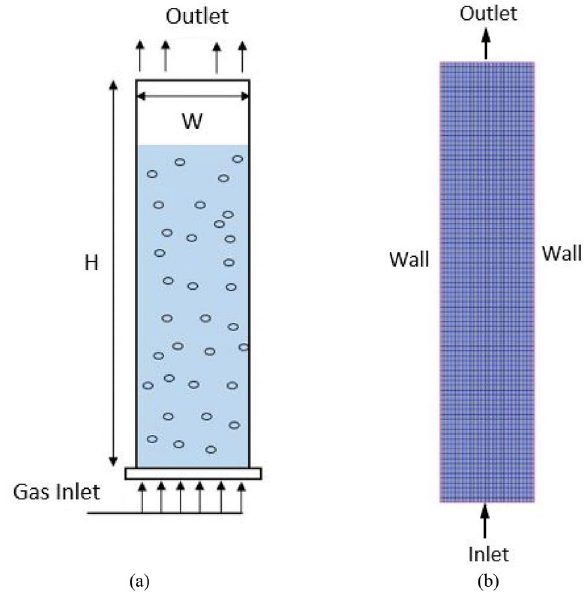
Fig. 1 a Schematic diagram and b computational mesh of the bub- ble